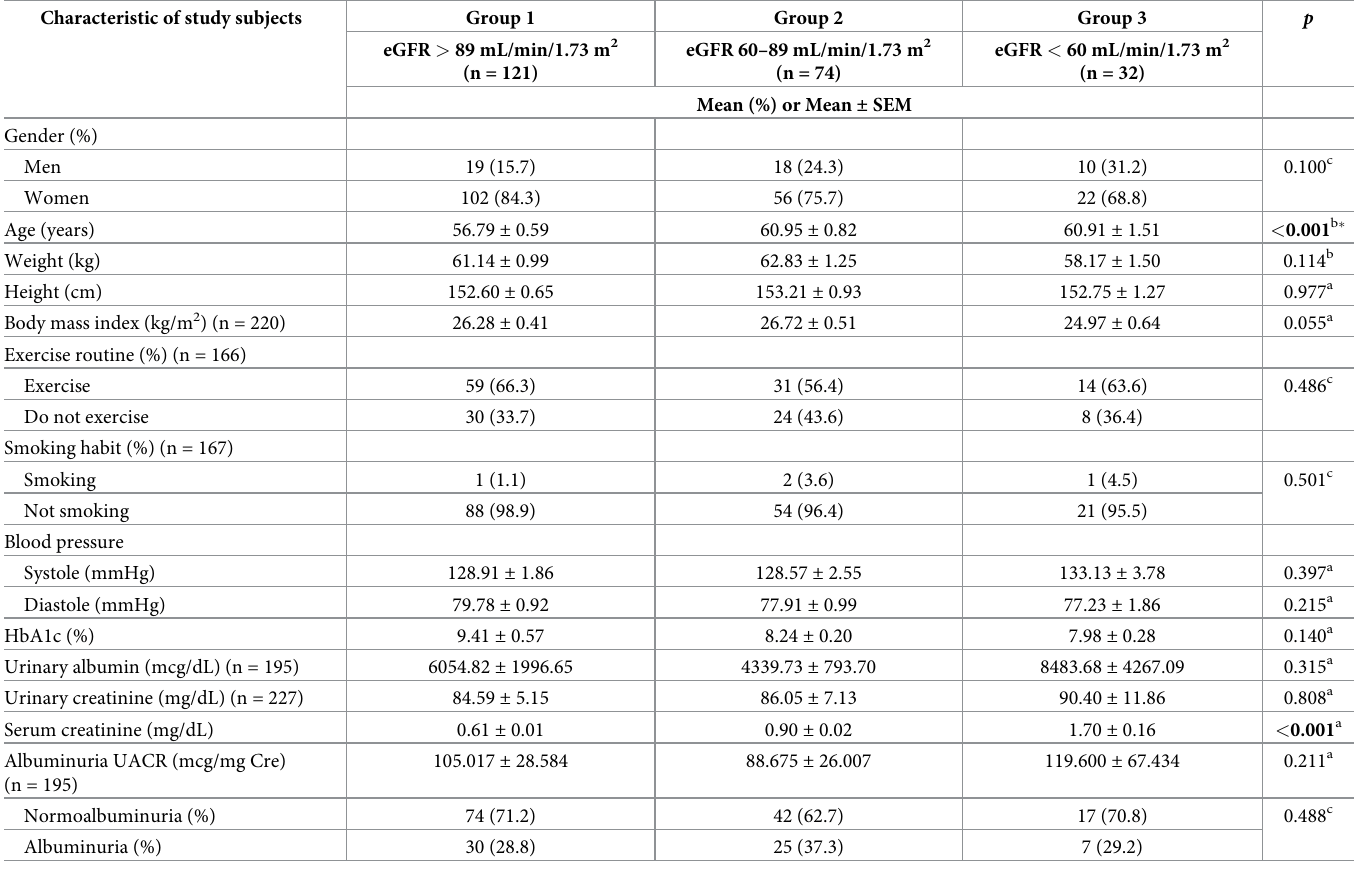
Table 1. Basic characteristics of study